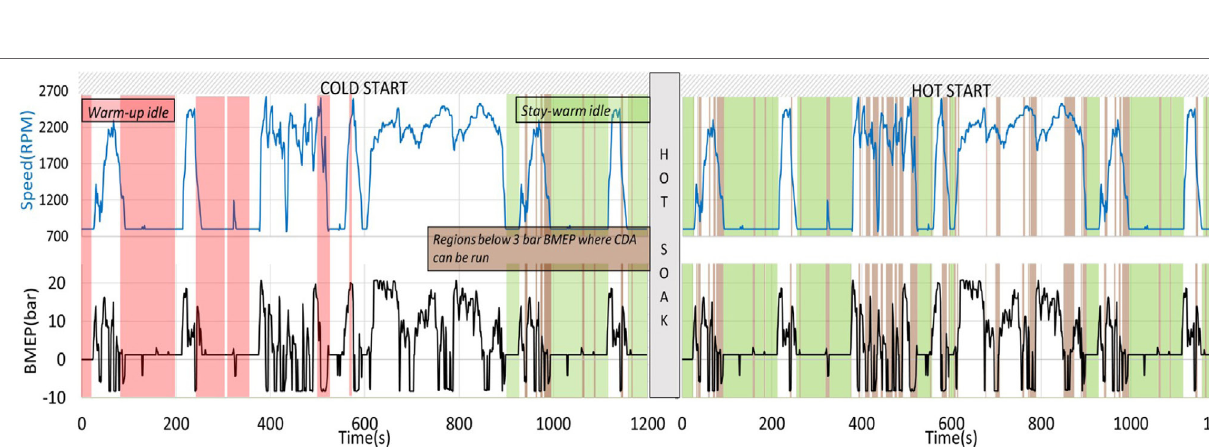
FigUre 13 | Test sequence for the HD-FTP cycle. Shaded red sections correspond to “A/T warm-up” idle operation. Shaded green sections correspond to “A/T stay-warm” idle operation while shaded brown sections correspond to “A/T stay-warm non-idle” where BMEP < 3 bar. For the “Six-cylinder A/T thermal management cycle,” the “Six-cylinder A/T warm-up idle” and “Six-cylinder A/T stay-warm idle” strategies are used during the warm-up and stay-warm idle sections, respectively. For the “Half-engine CDA A/T stay-warm idle cycle” the “Six-cylinder A/T warm-up idle” and “Half-engine CDA A/T stay-warm idle” strategies are used during the warm-up and stay-warm idle sections, respectively. For the “Six-cylinder best engine efficiency cycle” the “Six-cylinder best engine efficiency idle” strategy was used for both the warm-up and stay-warm, idle sections.